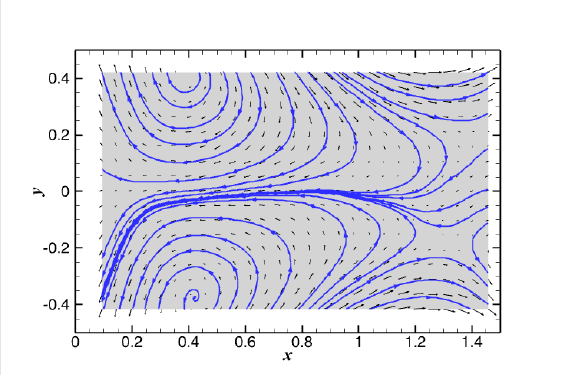
Fig. 6. The mean velocity field in the plane z = 1.4